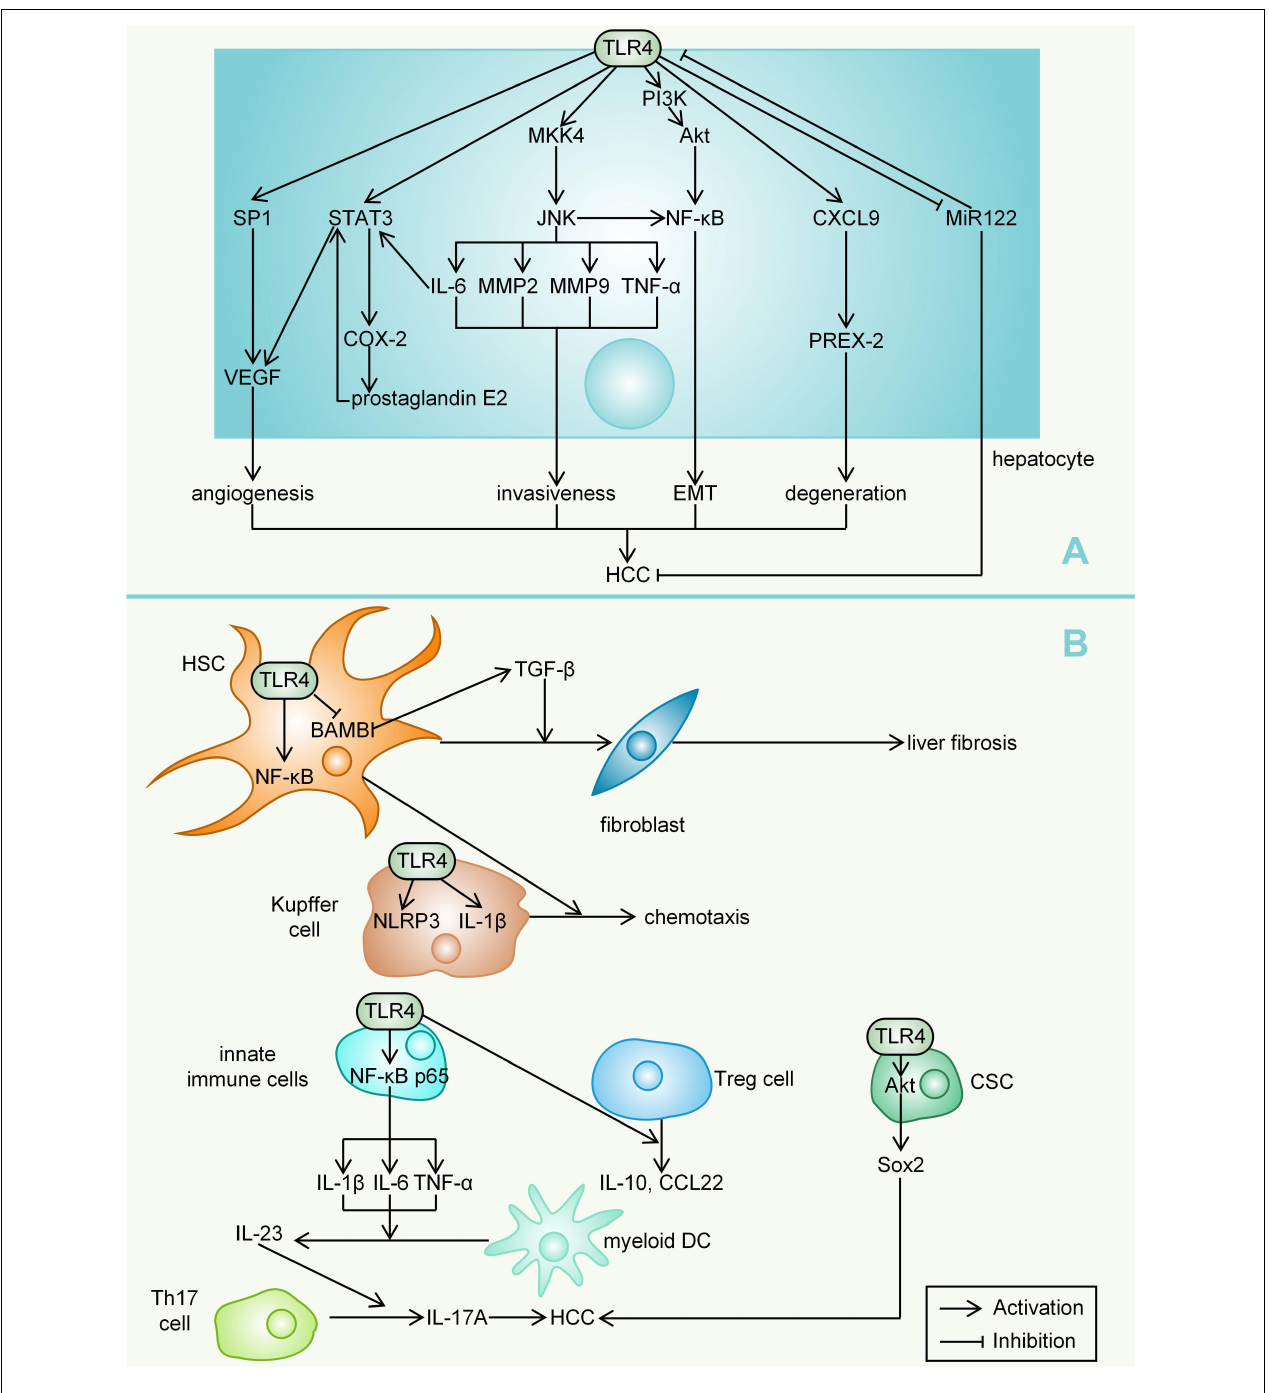
FIGURE 3 | Mechanisms by which TLR4 mediates HCC. (A) For hepatocytes, TLR4 can lead to angiogenesis (activation of VEGF), invasiveness (through multiple inflammatory mediators), EMT, degeneration (activation of PREX-2) and downregulation of miR122, ultimately promoting the development of HCC. (B) In other liver cells, TLR4 expression also activates signals (such as NF- κ B, interleukin and TNF- α ) that promote HCC development. LPS, lipopolysaccharide; HMGB1, high-mobility group box 1; MKK4, MAP kinase 4; JNK, c-Jun N-terminal kinase; MMP, matrix metallopeptidase; EMT, epithelial mesenchymal transition; PREX-2, phosphatidylinositol-3, 4, 5-trisphosphate RAC exchanger 2; VEGF, vascular endothelial growth factor; SP1, specificity protein 1; miR-122, microRNA-122; PI3K, phosphoinositide 3-kinase; Akt, protein kinase B; BAMBI, bone morphogenetic protein and activin membrane bound inhibitor; TGF, transforming growth factor; NLRP3, NLR family pyrin domain-containing 3; Th17 cell, T helper 17 cell; Pten, phosphatase and tensin homologue; Treg cell, regulatory T cell; CCL22, C-C class chemokine 22; SOX2, SRY-box containing gene 2; CSC, cancer stem cell.